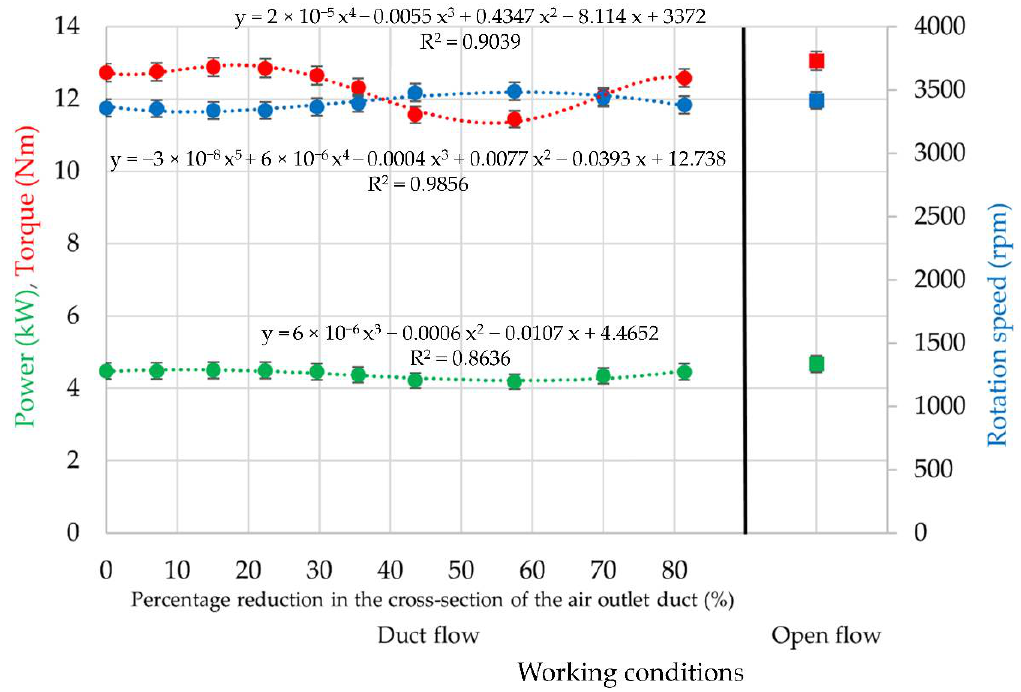
Figure 8. Characteristics of changes in the average power, torque, and speed during tests of fan W2